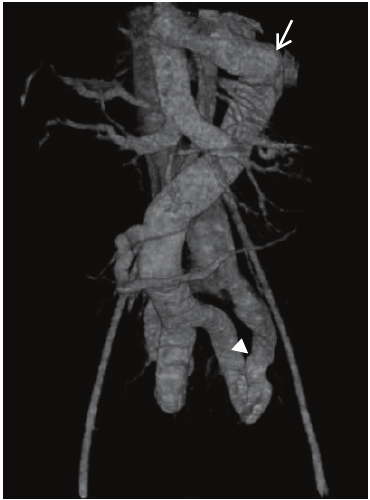
Figure 7: A 9-year-old boy with bleeding per rectum since he was 1 year old. Volume rendered CT image reveals dilatation of superior mesenteric vein and inferior mesenteric vein (arrow) with abnormal communication between iliac vein and branches of inferior mesenteric vein (arrow head).